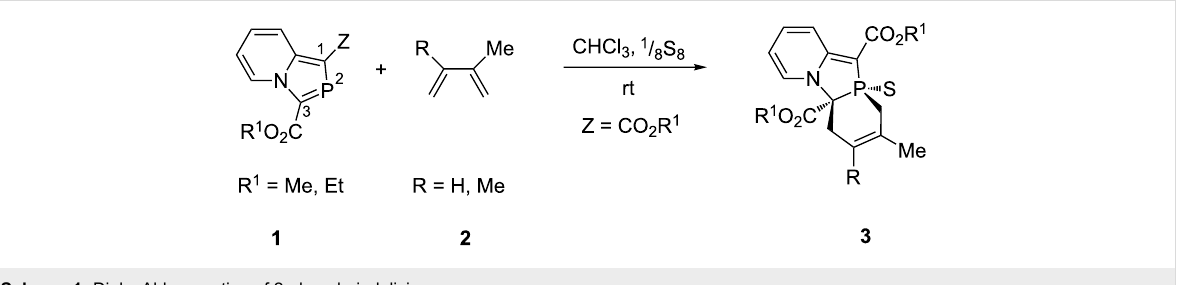
Scheme 1: Diels–Alder reaction of